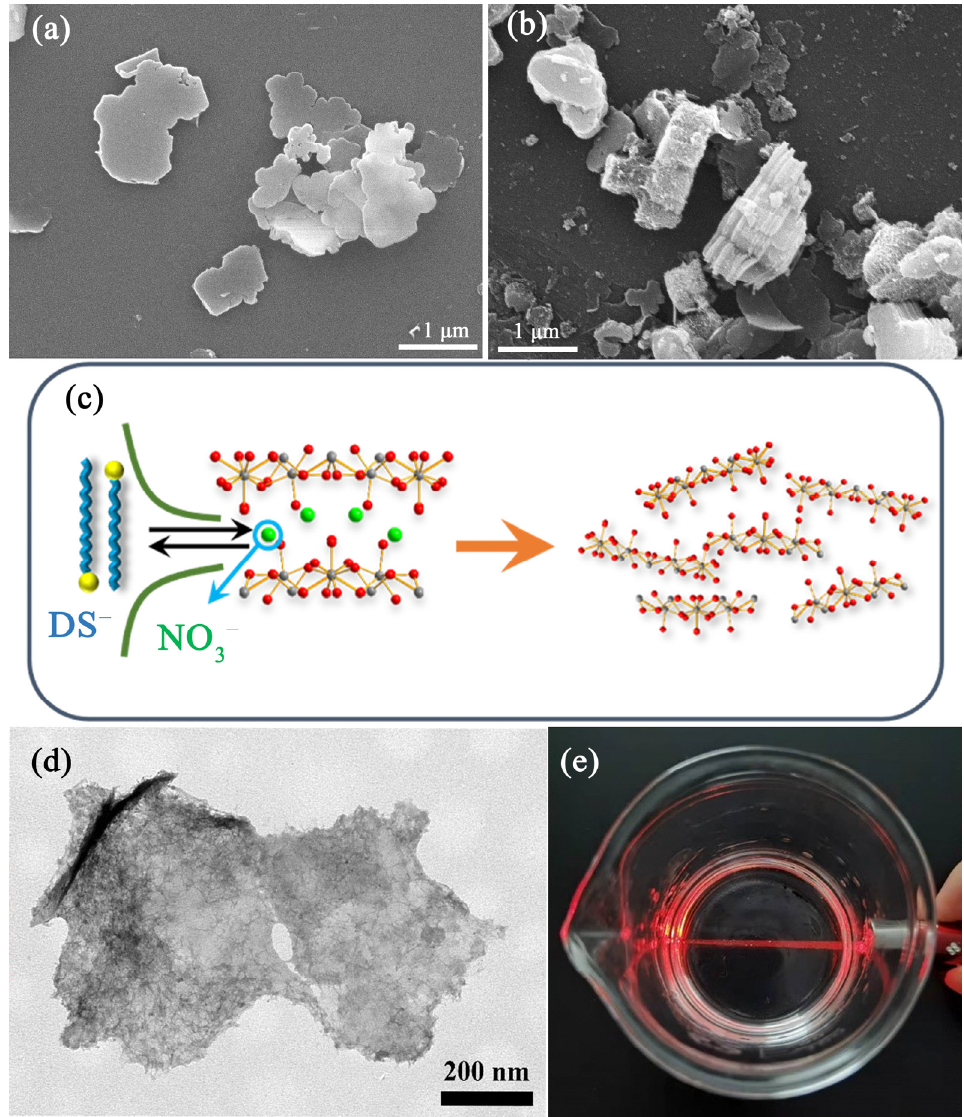
Figure 2. FE-SEM images of ( a ) layered rare-earth hydroxide and ( b ) anion-exchanged product. ( c ) Schematic illustration for nanosheet exfoliation. ( d , e ) TEM image of exfoliated nanosheets and colloidal suspension containing the exfoliated nanosheets.